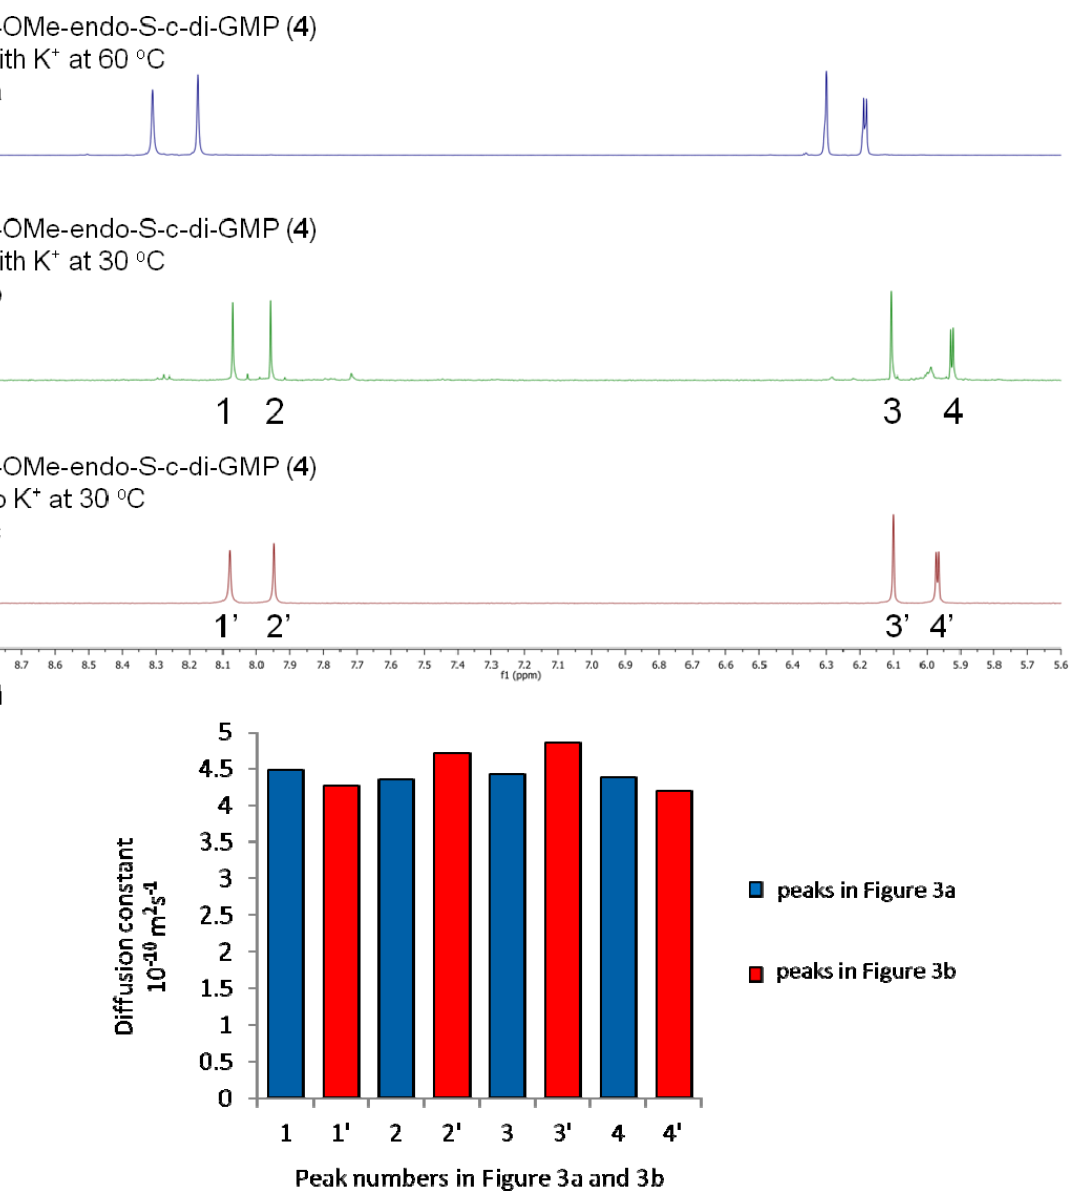
Figure 3. 1 H-NMR stacked spectra of 3.0 mM analogue 4 in D endo-S-c-di-GMP, 100 mM KCl, 60 °C. ( b ) 3.0 mM 2'-OMe-endo-S-c-di-GMP, 100 mM KCl, 30 °C. ( c ) 3.0 mM 2'-OMe-endo-S-c-di-GMP, no metal cation, 30 °C. ( d ) 3.0